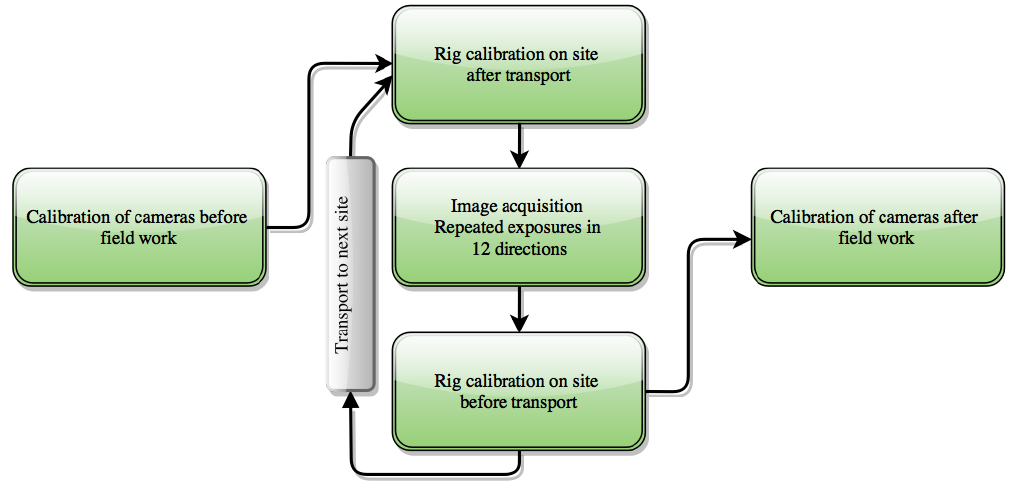
Figure 5. Calibration and image acquisition workflow. The cameras were individually calibrated at the beginning and the end of the campaign. The assembled camera rig was calibrated before and after each forest excursion. The rig calibration serves the dual purpose of not requiring exact camera mounting and guards against disturbance during transportation between and to/from the